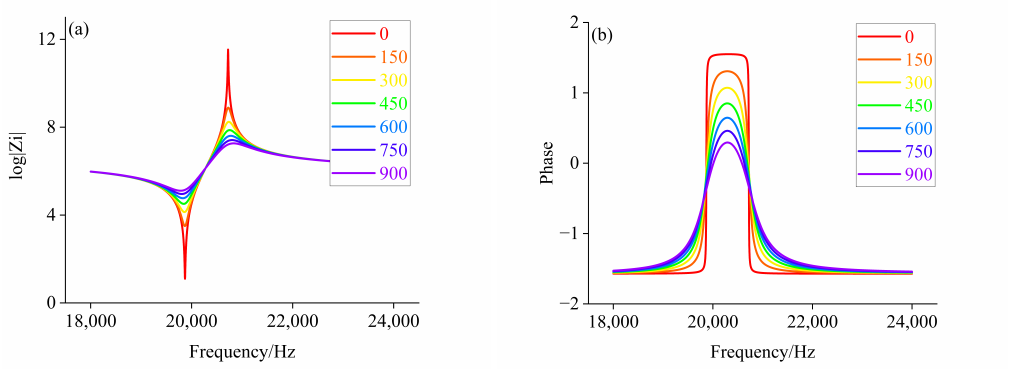
Figure 7. ( a ) Amplitude value characteristics when Z ft is a resistive load; ( b ) Phase frequency characteristics when Z ft is a resistive load.